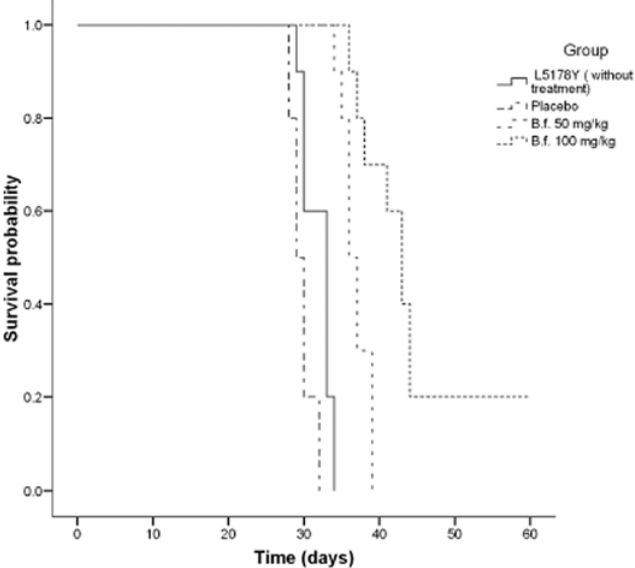
Figure 1. Antitumor activity of Bursera fagaroides var. fagaroides HA extract